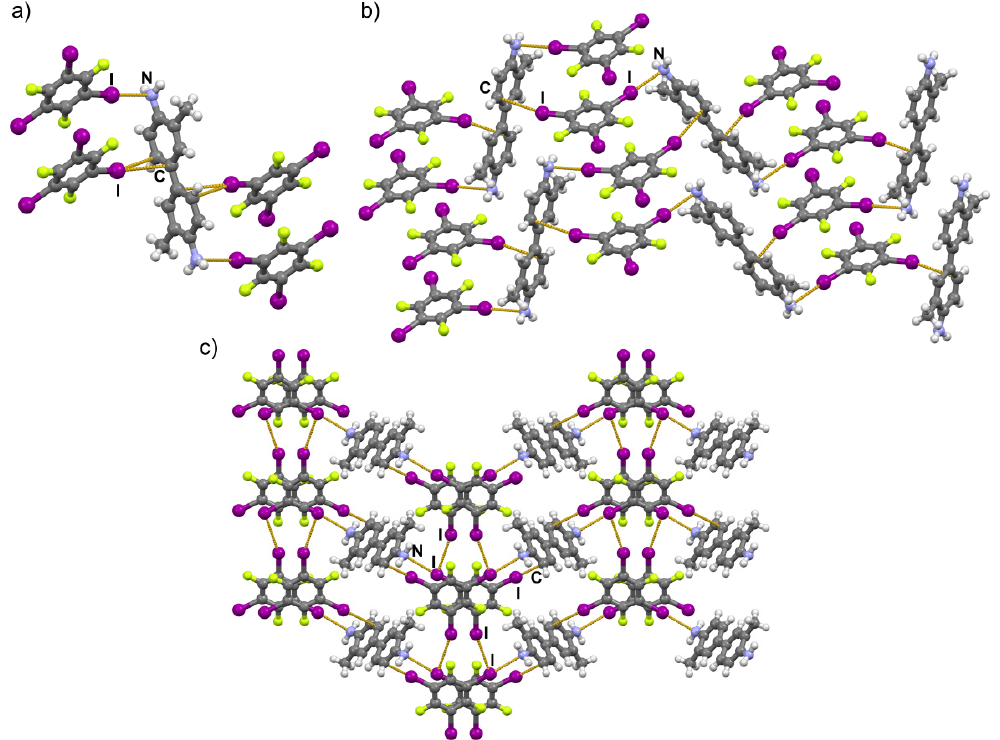
Figure 3. ( a ) Halogen bonding between otol and 135tfib molecules in the structure of ( otol )( 135tfib ) 2 ; ( b ) a layer formed by linking otol and 135tfib molecules via I ··· NH 2 and I · · · C π halogen bonds in the structure of ( otol )( 14tfib ); ( c ) layers connected through type II I ··· I contacts into a 3D structure.